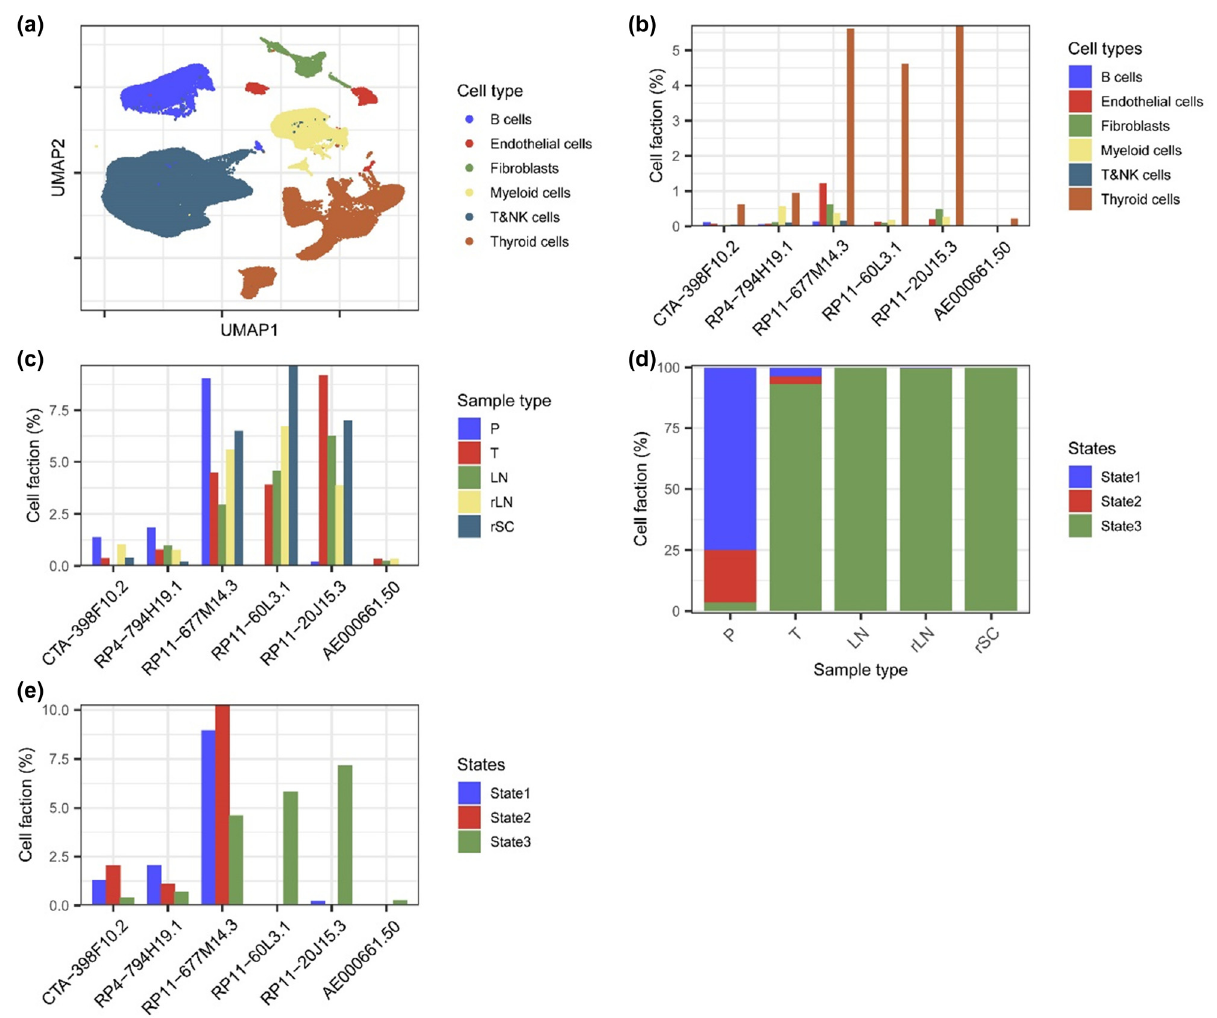
Figure 11: Exploration of the lncRNAs in papillary thyroid carcinoma at a single cell level. Single - cell RNA sequencing data of 22 samples from PTC patients were obtained from the GSE184362 dataset. ( a ) Cells were clustered into six main types and visualized by UMAP plot. ( b ) Proportions of the cells with di ff erent lncRNAs expression in di ff erent cell clusters. ( c ) Proportions of the thyroid cells with di ff erent lncRNAs expression in di ff erent sample types. P, paired adjacent normal tissues; T, primary tumors; LN, initially treated involved lymph nodes; rLN, recurrent LN; rSC, recurrent subcutaneous metastases. ( d ) Proportions of the thyroid cells with di ff erent state statuses in di ff erent sample types. ( e ) Proportions of the thyroid cells with di ff erent lncRNAs expression in di ff erent state